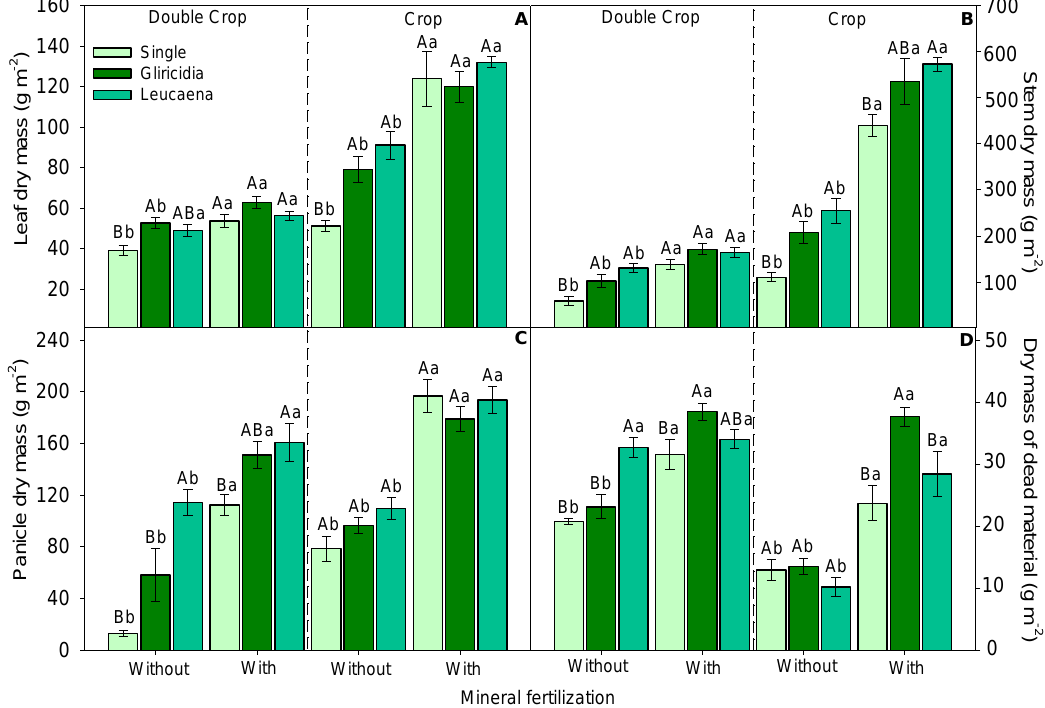
Figure 4. Leaf dry mass ( A ), stem dry mass ( B ), panicle dry mass ( C ), and dry mass of dead material ( D ) of forage sorghum submitted to the combination of leguminous alleys and mineral fertilization. Averages followed by the same lowercase letter for fertilization and uppercase letter for cropping systems were found by the Tukey test to not differ from each other at 5%.